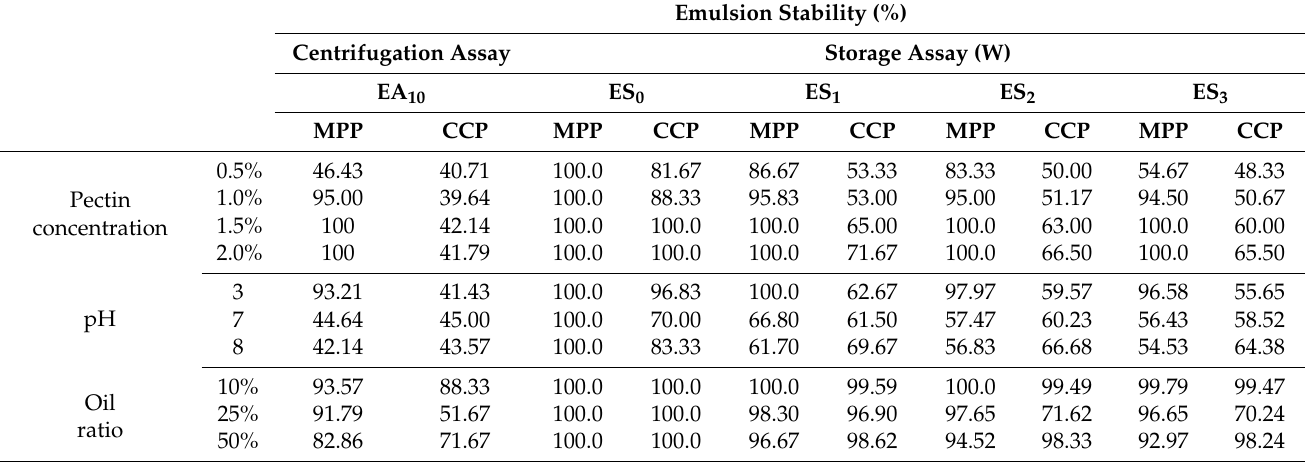
Table 7. Centrifugation and storage stability of MPP and CCP emulsions prepared by different